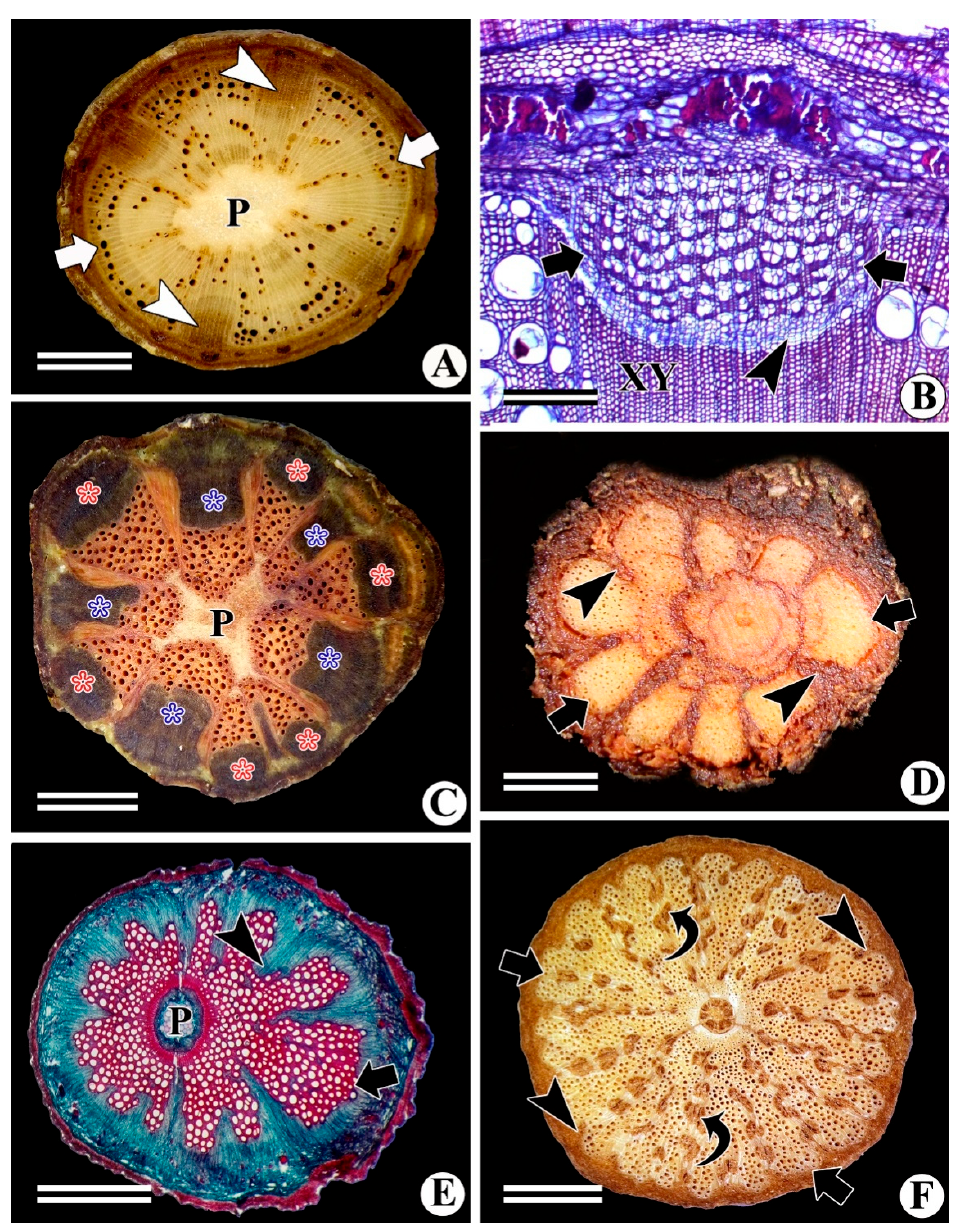
Figure 16. Transverse view of macro-morphology of young and mature stems ( A , C – F ) and section ( B ) of various taxa showing phloem wedges. ( A ) The young stem of Mansoa alliacea (syn. Bignonia alliacea ) shows four phloem wedges (arrowheads), with arrows indicating interwedges. ( B ) Portion of phloem wedge (arrows) in Arrabidaea candicans showing the variant cambium that results in the phloem wedge (arrowhead). ( C ) Thick stem of Serjania mexicana showing phloem wedges (asterisks). Initially formed phloem wedges with blue asterisks and later formed phloem wedges shown with red asterisks. ( D,E ) Mature stem of Diplopterys carvalhoi ( D ), and Jacquemontia pentanthos ( E ) showing phloem wedges (arrowheads), with arrows indicating interwedges. ( F ) The mature stem of Neuropeltis racemosa showing phloem wedges (arrowheads) and interwedges (arrows). The curved arrows indicate wedges enclosed within the secondary xylem. Abbreviations : P = pith, XY Secondary xylem. Scale bars : A = 2 mm; B = 200 µm; C, E, F = 5 mm; D = 7 mm.